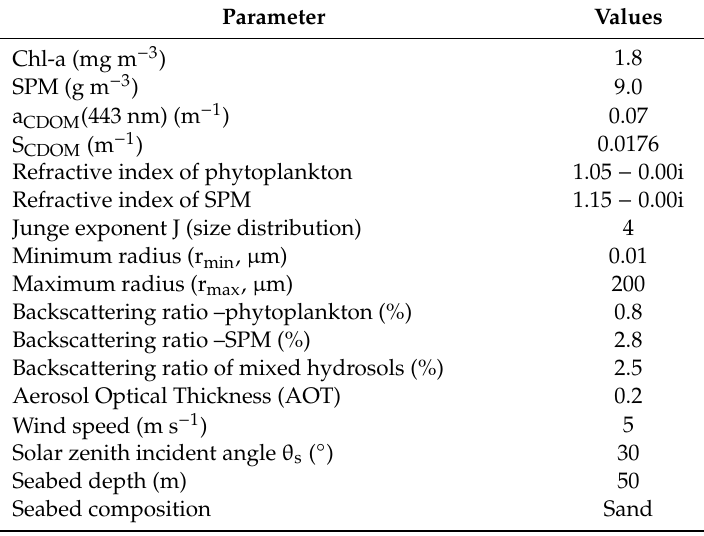
Table 1. Values of the parameters used for the benchmark case of simulation as inputs of the OSOAA radiative transfer